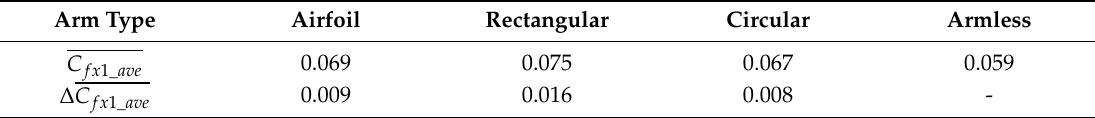
Figure 20. Distribution of the x 1 -direction friction-based force coe ffi cients on each half-blade. The data at the respective span position were averaged over the seventh rotor-revolution using Equation (9). Table 6. Middle row shows the friction-based force coe ffi cients averaged along the half-blade span direction. The values in the bottom row are friction-based tangential force coe ffi cients obtained from the di ff erence between each force coe ffi cient and that of armless